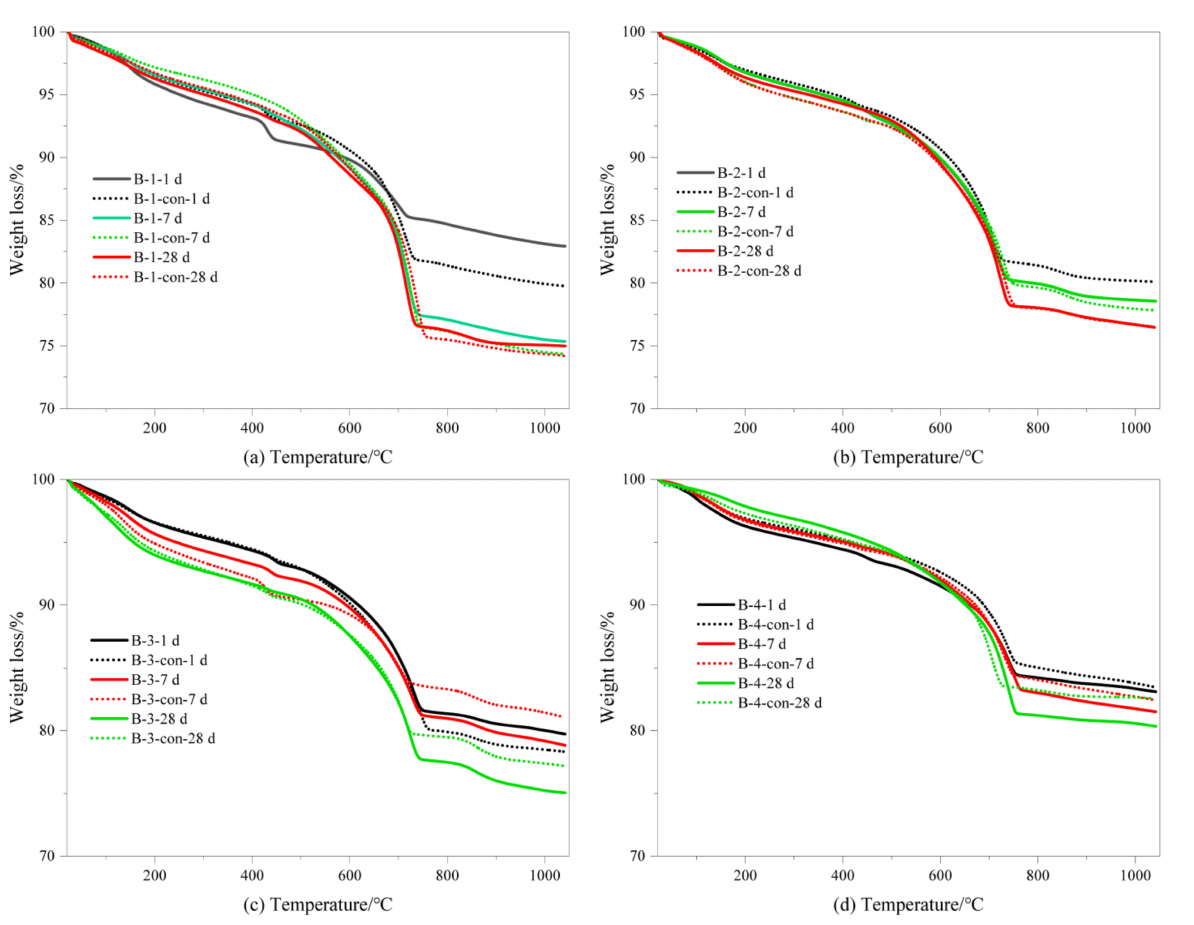
Figure 12. Weight loss of different cement-based composites of B-1 series ( a ), B-2 series ( b ), B-3 series ( c ) and B-4 series ( d ) with different ages by